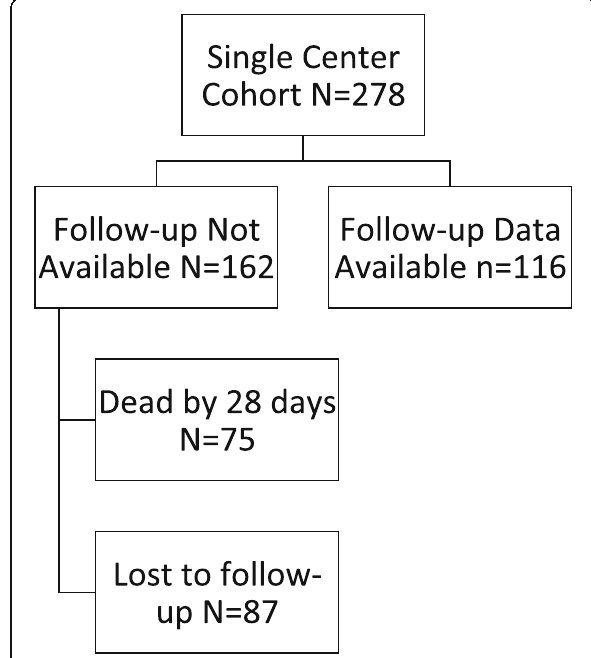
Fig. 1 Ascertainment of patients in the single center